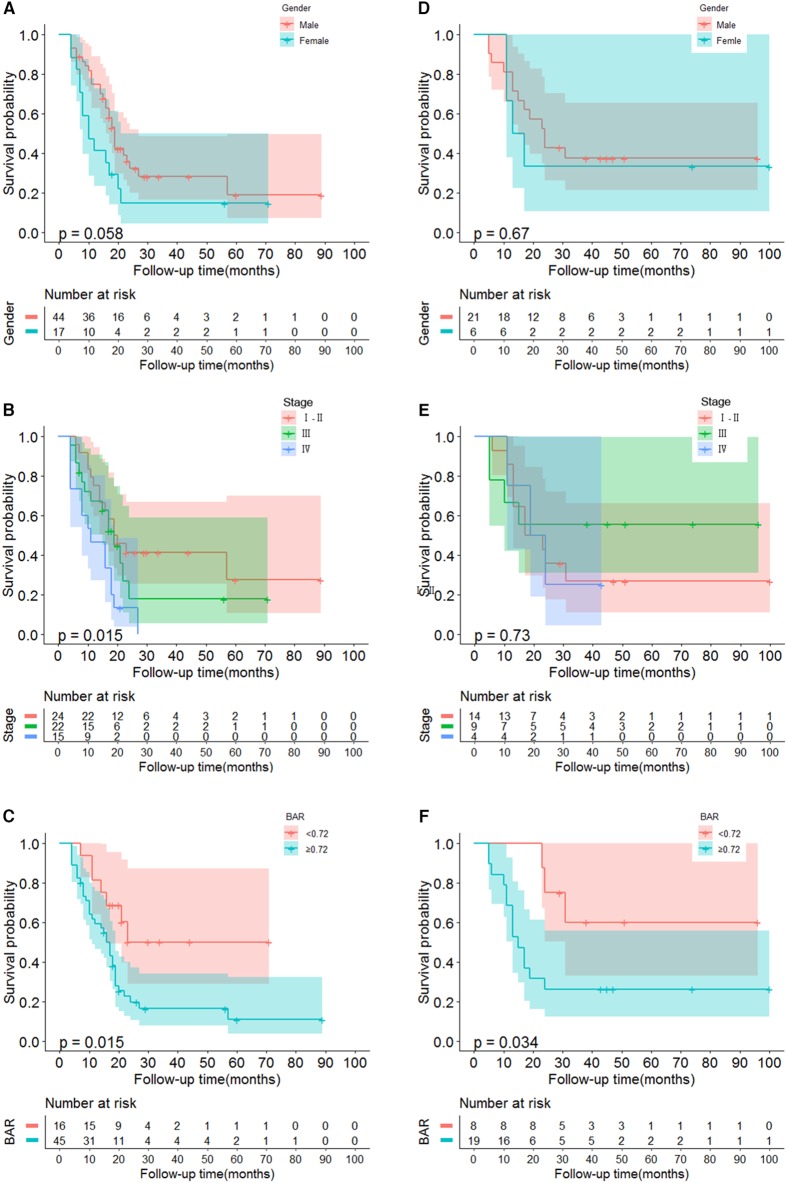
Kaplan-Meier curves for OS in SCCE patients. (A–C) The gender, TNM, BAR in SCCE patients in training cohort are plotted as a distribution. (D–F) The gender, TNM, BAR in SCCE patients in validation cohort are plotted as a distribution. BAR, ApoB/ApoA-1.